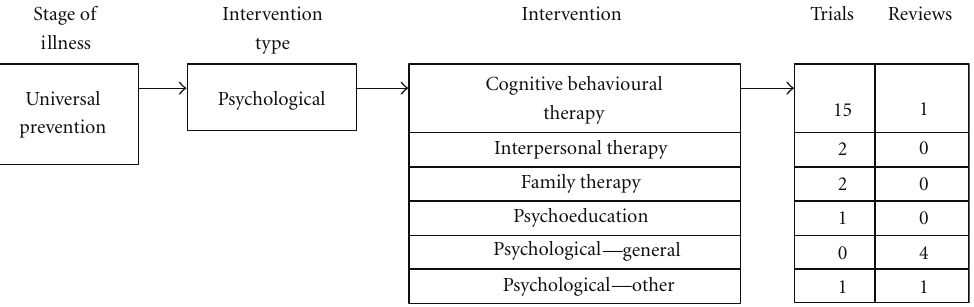
Figure 2: Flowchart for included studies.